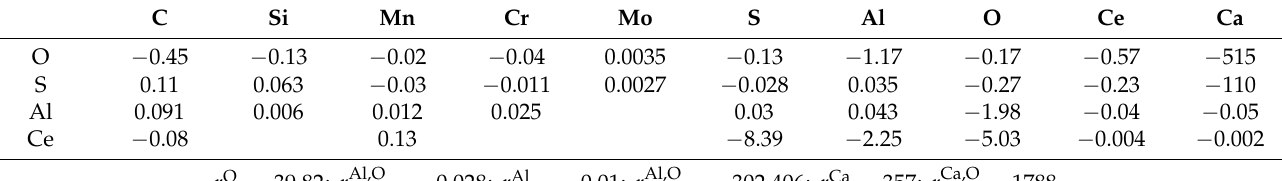
Table 4. Interaction coefficients of elements involved in the study